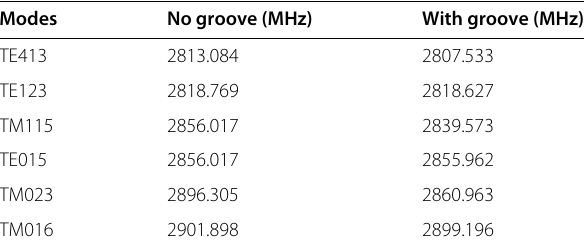
original SLEDs due to the RF breakdown. In the original SLED, the 3-dB power hybrid is combined with the two cylindrical cavities through the single-iris coupling struc- ture. High radiation-dose rates were measured around the center of the 3-dB power hybrid and the cavity-waveguide coupling iris of the two cavities. Moreover, the S-band RF station of PAL-XFEL requires the RF output peak power of 80 MW with a repetition rate of 60